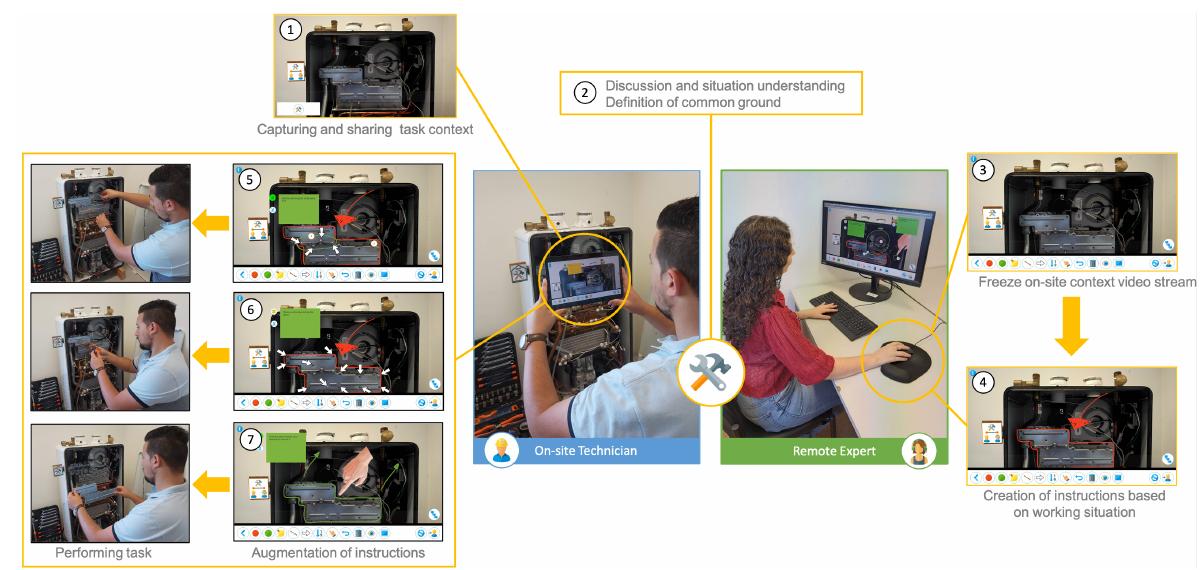
Figure 1. On-site technician performing an intervention based on a set of instructions provided by a remote expert using the proposed AR-based authoring tool. Adapted from [43].